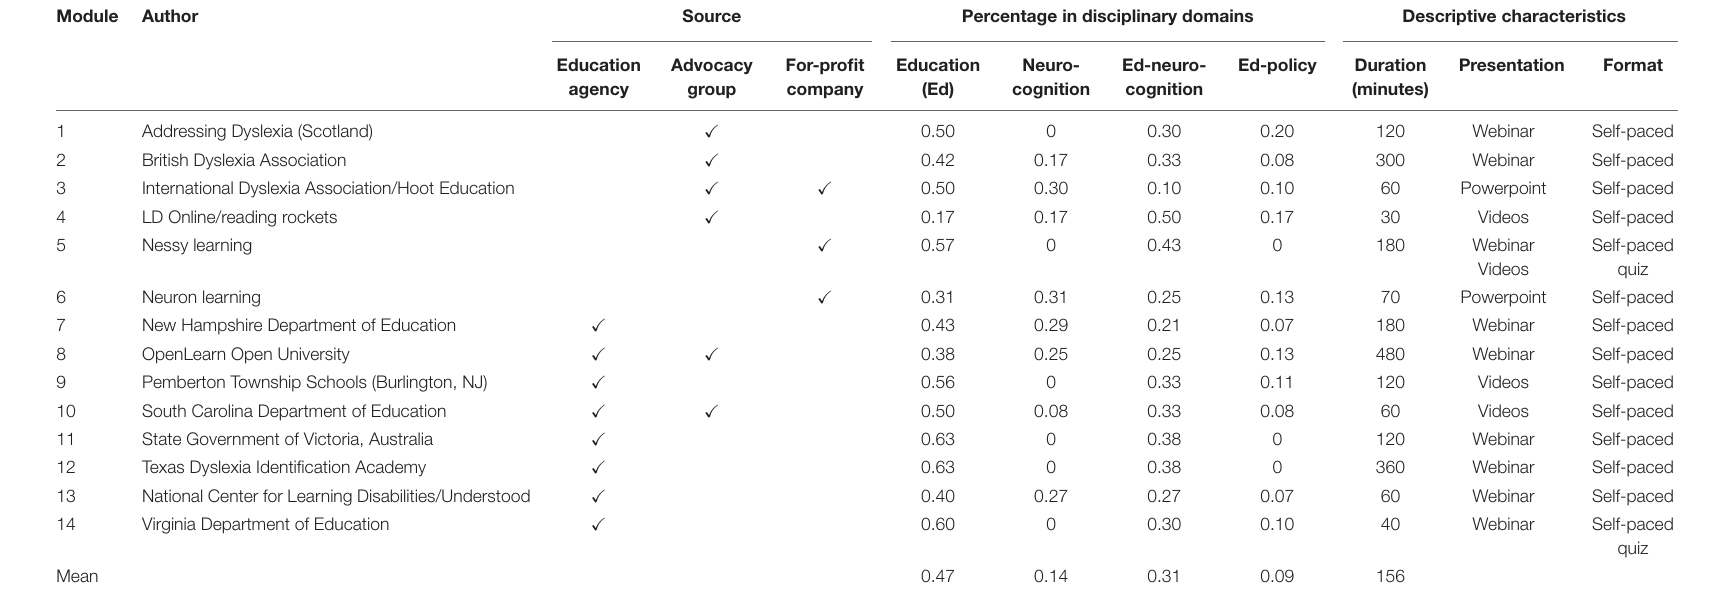
TABLE 2 | Author, source, percentage of topics in disciplinary domains, and descriptive characteristics of online dyslexia